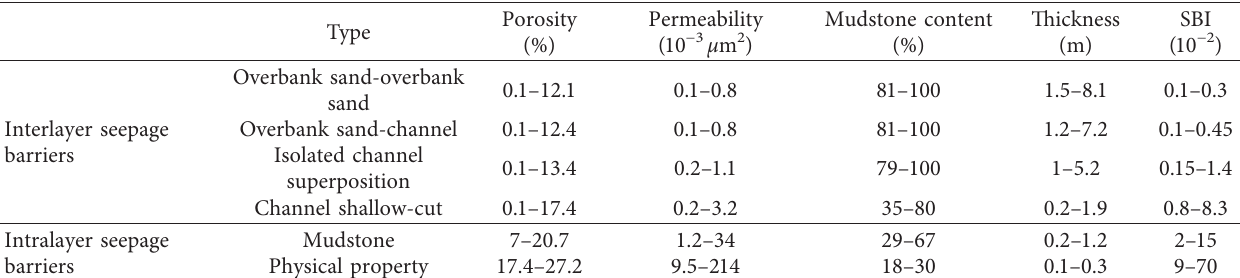
Figure 4: Scatter cross plot of SBI and permeability. (a) Relationship between SBI and permeability of interlayer seepage barriers. (b) Relationship between SBI and permeability of intralayer seepage Table 1: Parameters of interlayer and intralayer seepage barriers.